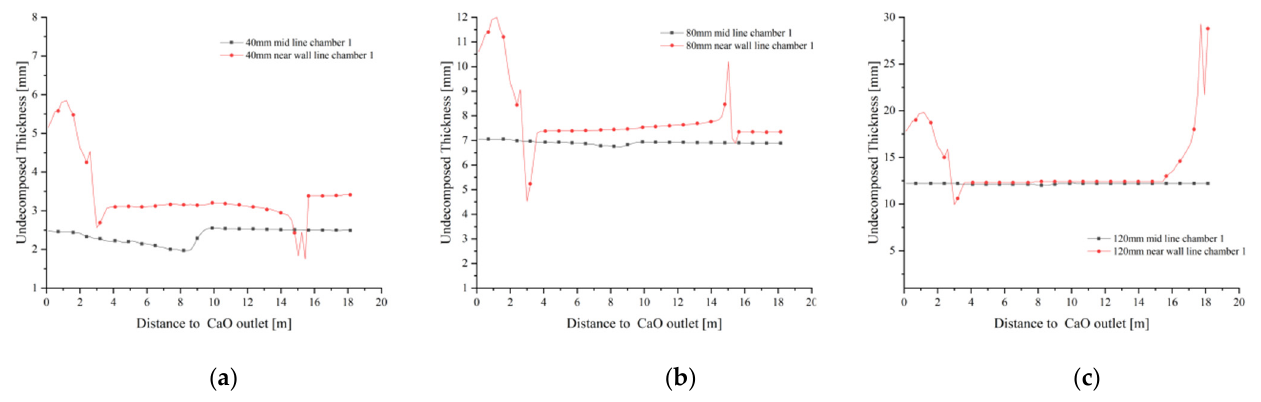
Figure 20. Variation of undecomposed thickness of CaCO 3 at 40 mm, 80 mm and 120 mm particle sizes. ( a ) Variation of undecomposed thickness of CaCO 3 at 40 mm ( b ) Variation of undecomposed thickness of CaCO 3 at 80 mm ( c ) Variation of undecomposed thickness of CaCO 3 at 120 mm. At the CaO outlet, the undecomposed thickness distribution is shown in Figure 21.